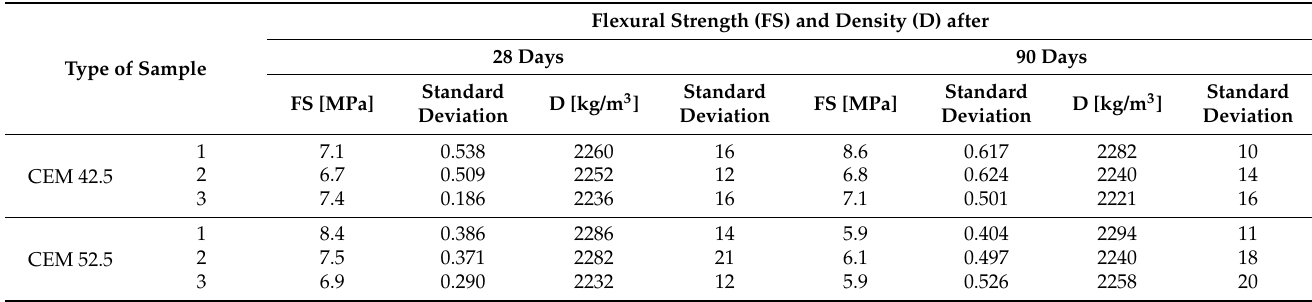
Table 6. Flexural strength and density of cement mortars after 28 and 90 days of curing.